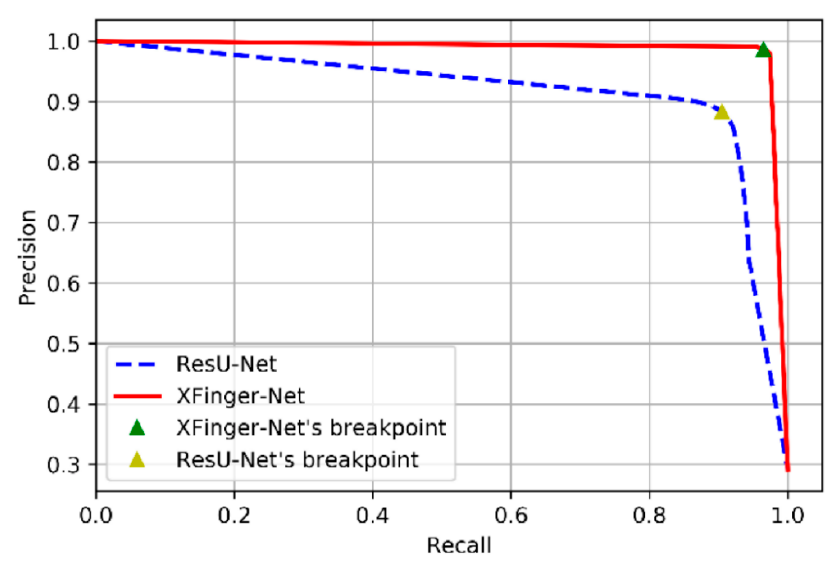
Figure 12. PR curve of XFinger-Net and ResU-Net.